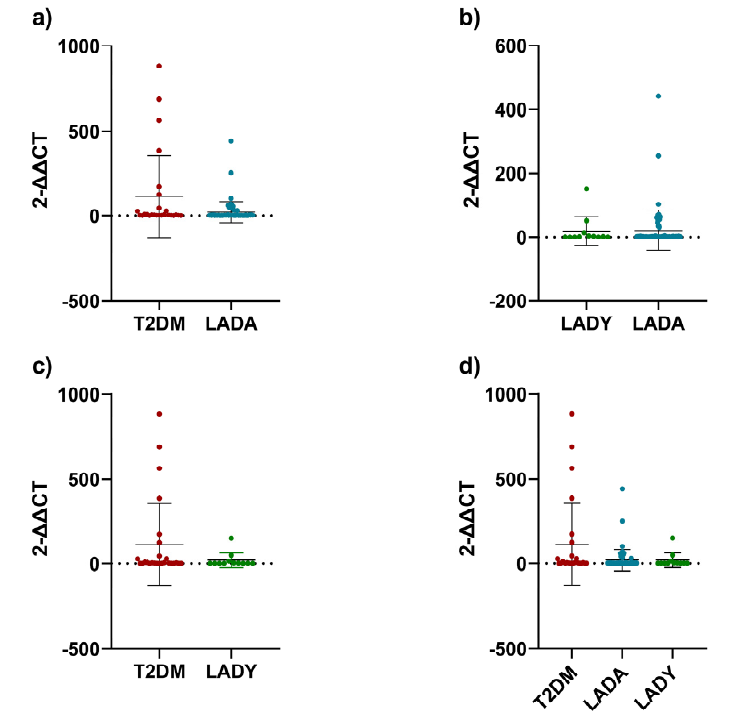
Figure 2. Telomere lengths. ( a ) T2DM group compared to LADA group; ( b ) LADY group compared to LADA group; ( c ) T2D group compared to LADY group; ( d ) three groups compared together. For the analysis in graphic ( a – c ), Mann-Whitney test was used. For graphic ( d ), Kruskal-Wallis test was used. All data points were included after adjusting the telomere length to obtain arithmetic normalization of the samples obtained from the DNA extraction and rt-PCR analysis. Error bars represent the standard deviation.